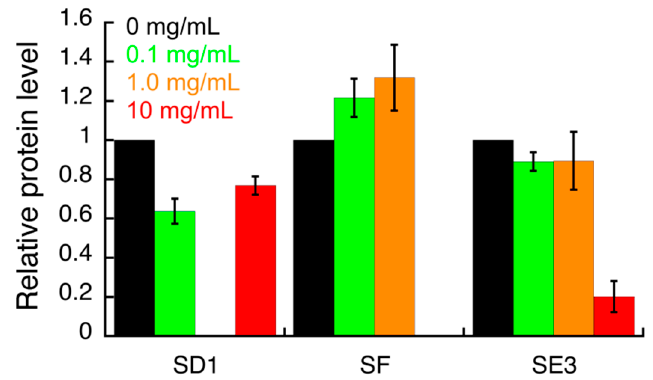
Figure 4. Densitometric analysis of the Western blot images (shown in the Supplementary Materials) indicating the effects of S. campanulata on H. pylori G27 CagA expression. H. pylori cells were treated with different concentrations of S. campanulata sub-fractions for 4 h and protein level of the virulence factor CagA was determined by Western blot, using a specific anti-CagA antibody. Values are expressed as means ± SD of two independent experiments. Sub-fraction SD1 (20% Cyhex/EtOAc), sub-fraction SE3 (70% MeOH/H 2 O), and sub-fraction SF (80% Cyhex/EtOAc) were from fractions D, E, and F, respectively.